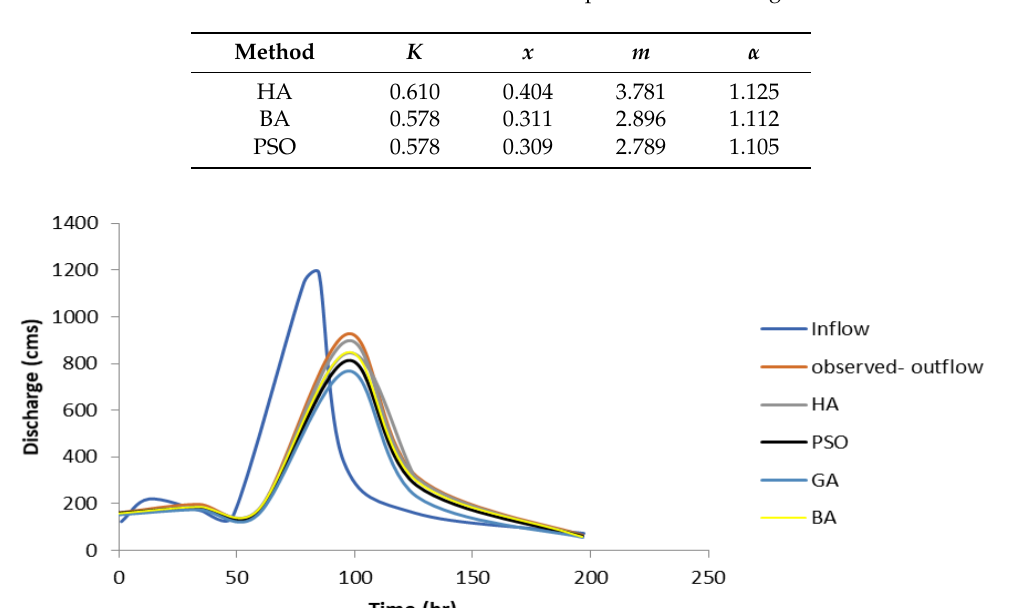
Figure 4. Simulated discharges by different algorithms for Karahan flood.